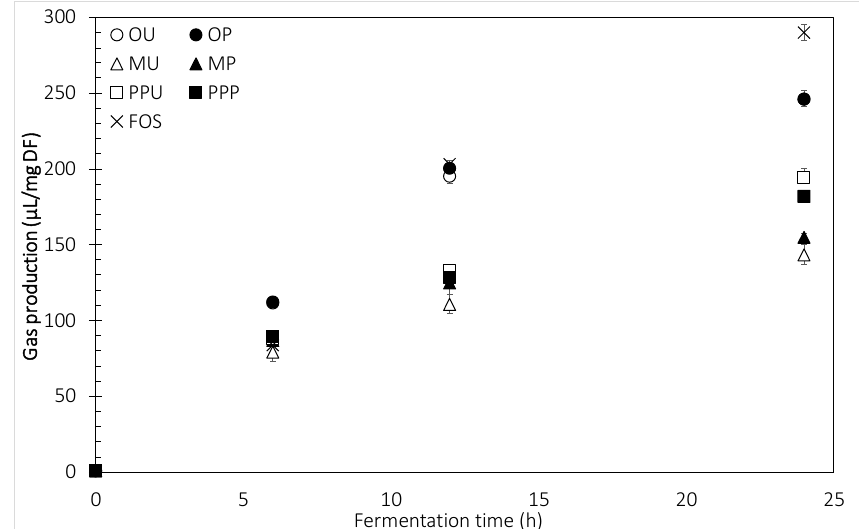
Figure 2. Gas produced during in vitro fermentation of untreated and HHP-treated fruit peels. Error bars show SD; some error bars are too small to see; n = 3. OU—orange untreated, OP—orange HHP-treated, MU—mango untreated, MP—mango HHP-treated, PPU—prickly pear untreated, PPP—prickly pear HHP-treated, FOS—fructo-oligosaccharides.